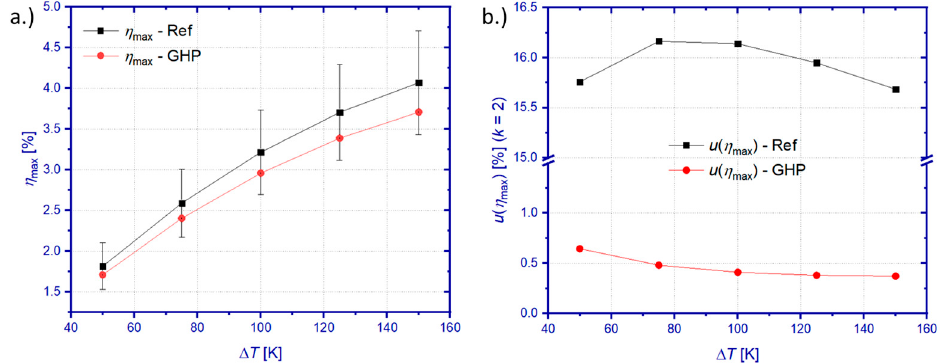
Figure 7. Best estimates for the maximum efficiency η max obtained from Equation (5) with data on power output and heat flow from the reference principle and the GHP method, respectively ( a ). The error bars, which are actually only visible for the reference principle, give combined uncertainties of the maximum efficiency u ( η max ) ( k = 2). These uncertainties have been determined for both heat flow measurement methods using Equation (27) ( b ).